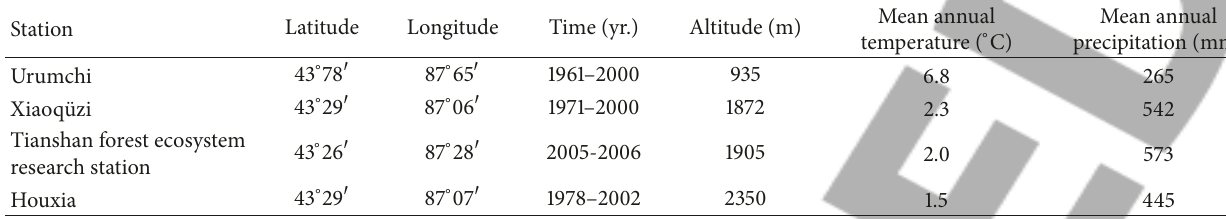
Table 1: Meteorological data of located stations within the research